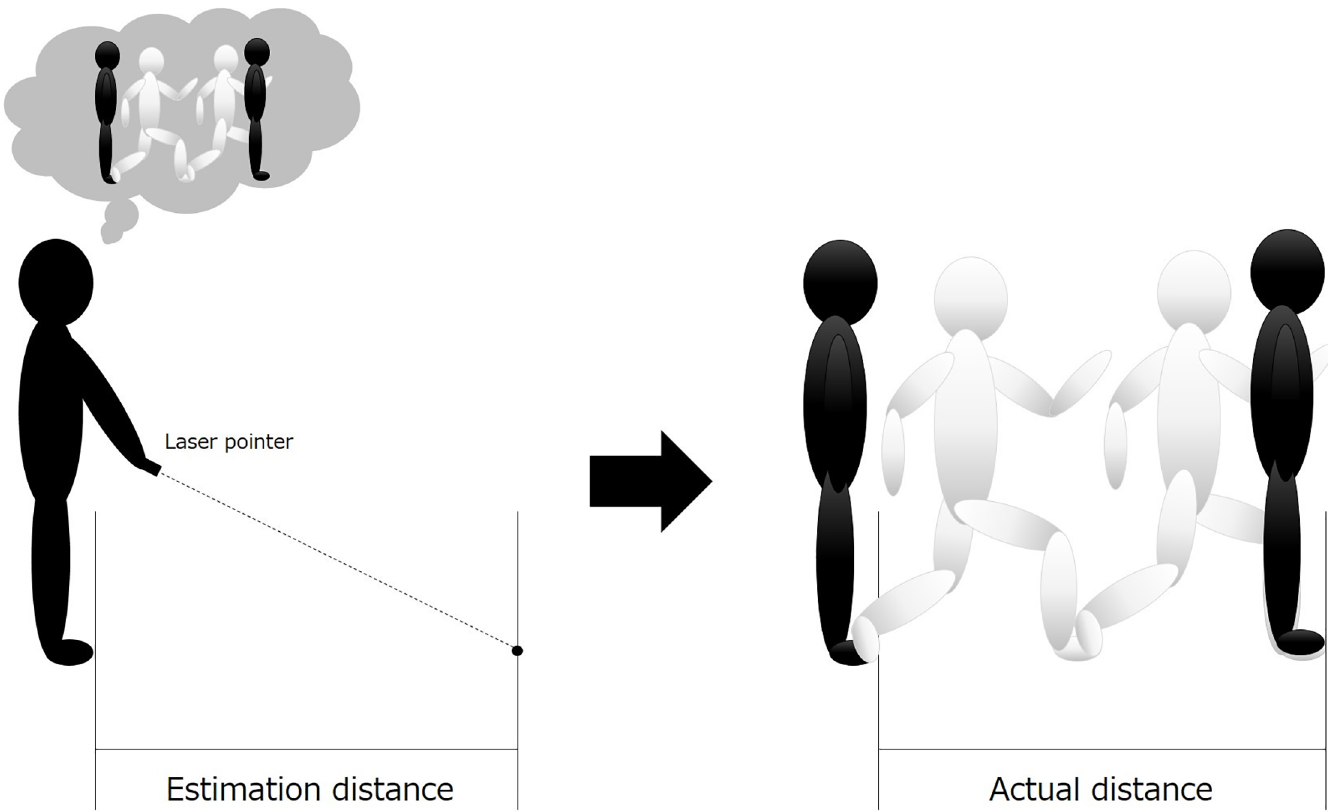
Fig 1. Schematic illustration of the two-step test. Participants estimated the two-step distance forward with maximum effort and indicated the distance using a laser pointer. After the estimation, the actual distance was measured.